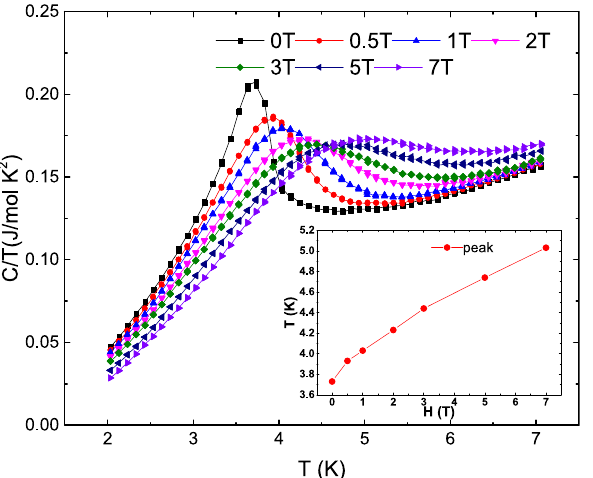
Figure 4. Low temperature specific heat data measured in different fields for H // b direction. The inset shows the evolution of the specific heat peak with the applied magnetic